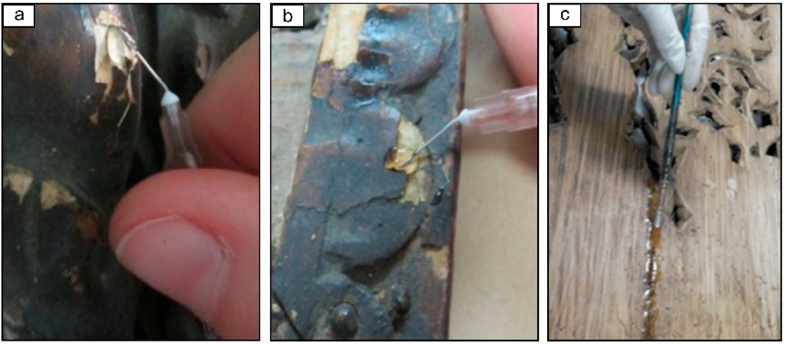
Figure 4. Consolidation in the volume phase of the weakened support: ( a , b ) Injection; ( c ) Brushing the Paraloid solution B 72.